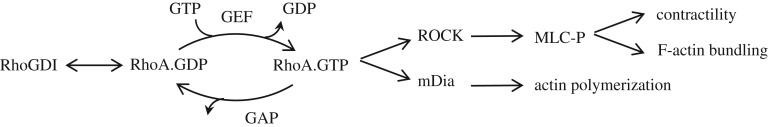
RhoA regulation. RhoA bound to GDP is inactive and can be sequestered by Rho guanine nucleotide dissociation inhibitor (RhoGDI). GDP exchange for GTP is promoted by guanine nucleotide exchange factors (GEFs), whereas GTP hydrolysis is stimulated by GTPase activating proteins (GAPs). In the active, GTP-bound state, RhoA activates the kinase ROCK which promotes contractility and bundling of actin filaments by activating myosin via phosphorylation of the regulatory myosin light chain (MLC). RhoA also binds and activates the formin mDia, stimulating actin polymerization.